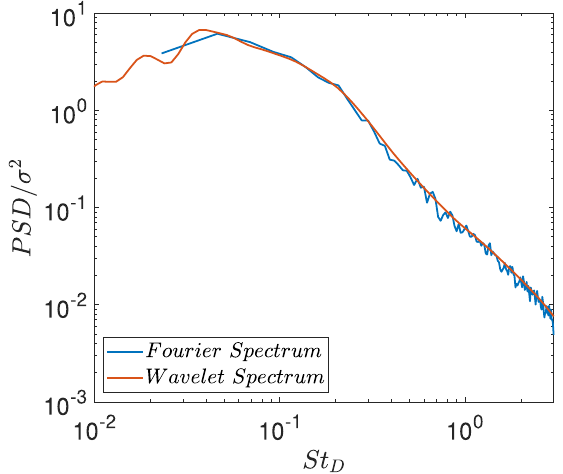
Figure 2. Comparison between a Fourier Power Spectrum (dotted line) and the corresponding wavelet-reconstructed Fourier Spectrum (solid line). Data are taken at TI = 9%, r / D = 3 and x / D =